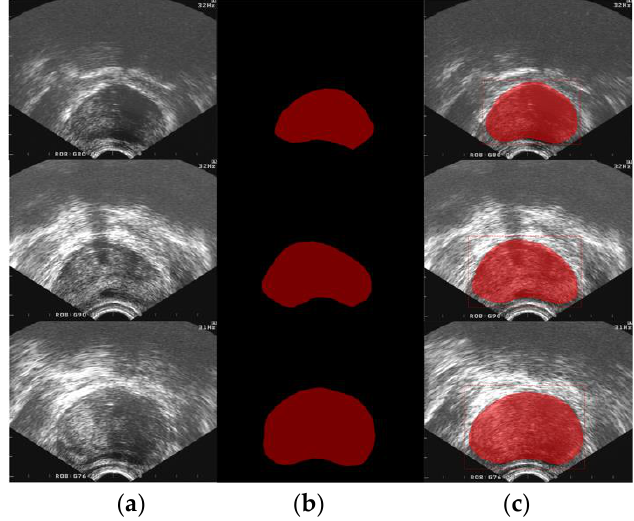
Figure 8. ( a ) Original prostate TRUS images. ( b ) Ground truth from the manual segmentation by a clinically experienced doctor. ( c ) Segmentation results of the proposed method.